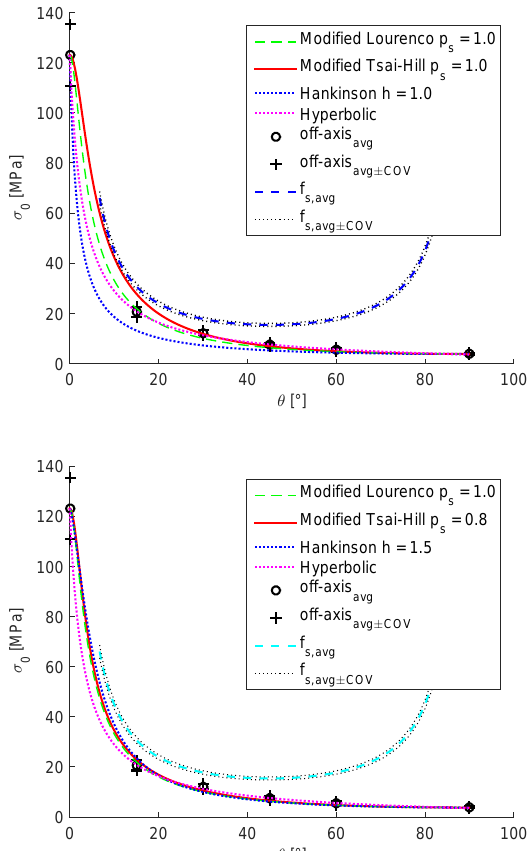
Figure 4. The experimental data of Douglas fir lam- inated veneer [19] with uncalibrated (top) and cali- brated (bottom) failure